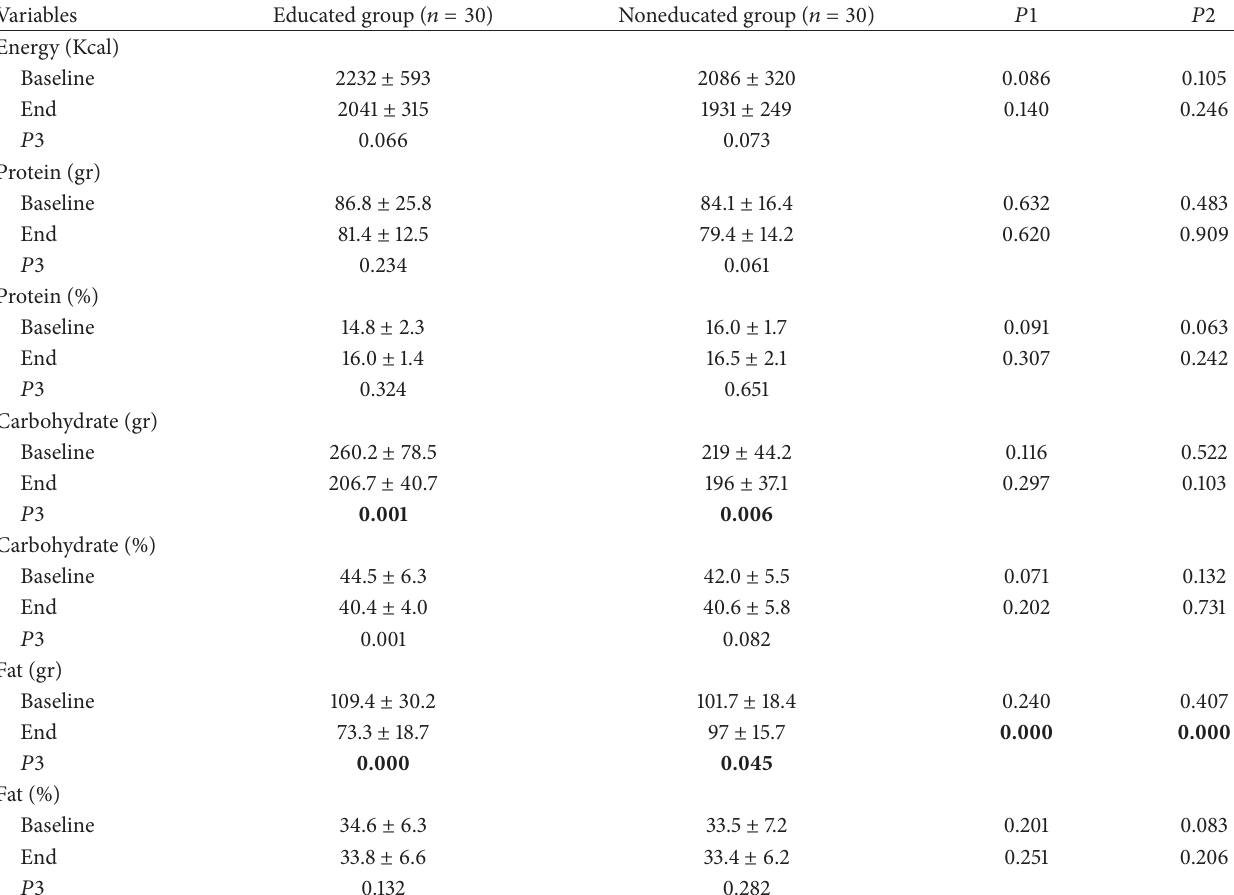
Table 2: Dietary intakes of the study groups at the baseline and end of